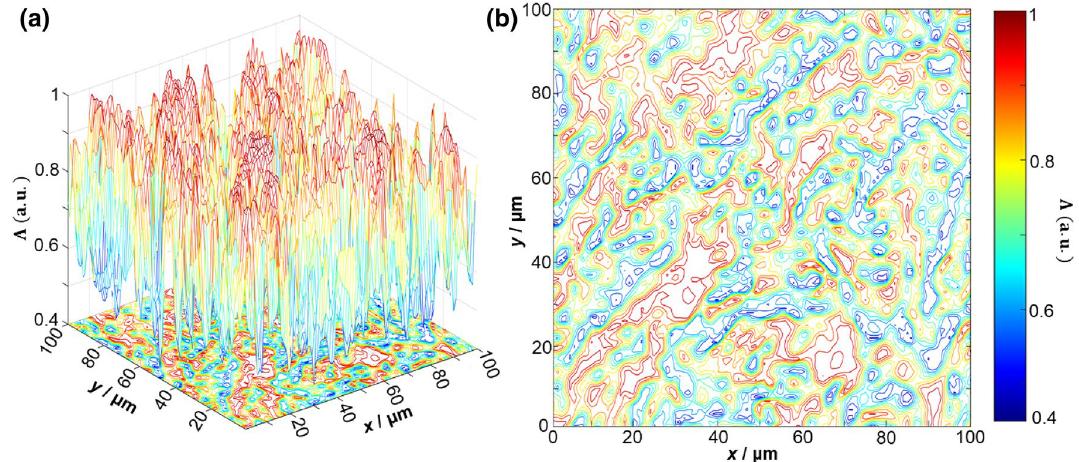
x , y , θ k = 0.85 rad of a sample of a (cid:30) (cid:31)